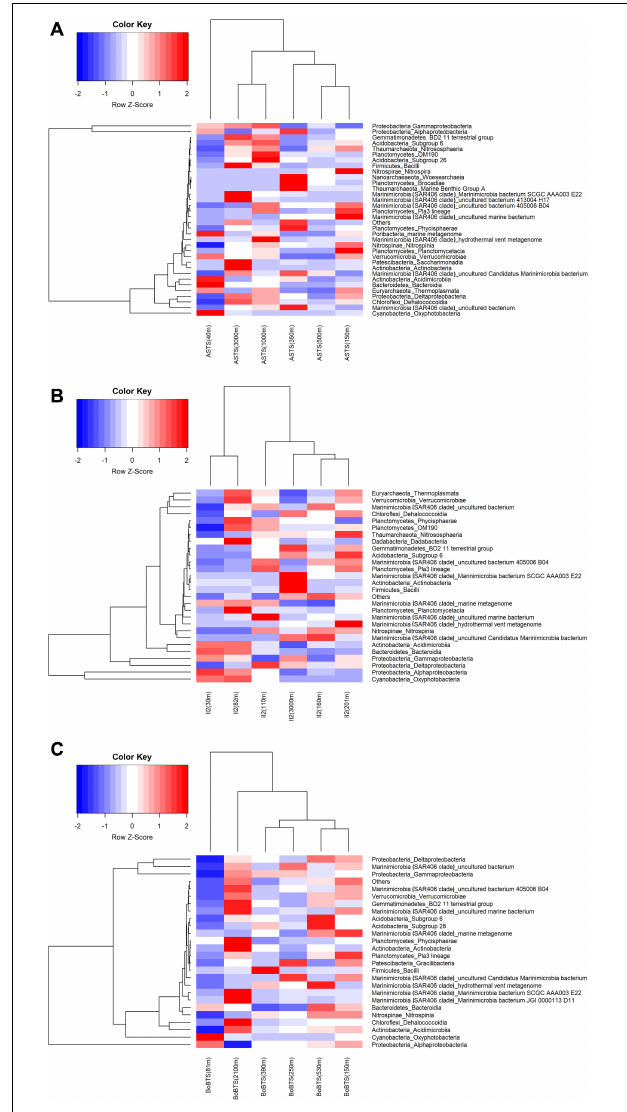
FIGURE 3 | Heatmap generated using the relative abundance of bacteria at phyla_class level. The x-axis represents the distribution of bacterial communities in the sampled depths and y-axis represents the class-level taxonomy. The heatmap scale displays the row Z score (Z score = [actual relative abundance of a bacterial taxa at class-level in a specific depth of the water column – mean relative abundance of the same taxa along the sampled depths in the water column]/standard deviation). Thus, the positive Z scores indicate values above the mean, while negative Z scores values are below the mean in units of standard deviation. The scaled data is then converted into colors. Hierarchal clustering is based on the Euclidian similarity index. (A) Heat map of > 0.01% relative abundance at class level for Arabian Sea time series (ASTS). (B) Heat map of > 0.01% relative abundance at class level for India’s Idea 2 (II2) . (C) Heat map of > 0.01% relative abundance at class level for Bay of Bengal time series (BoBTS).